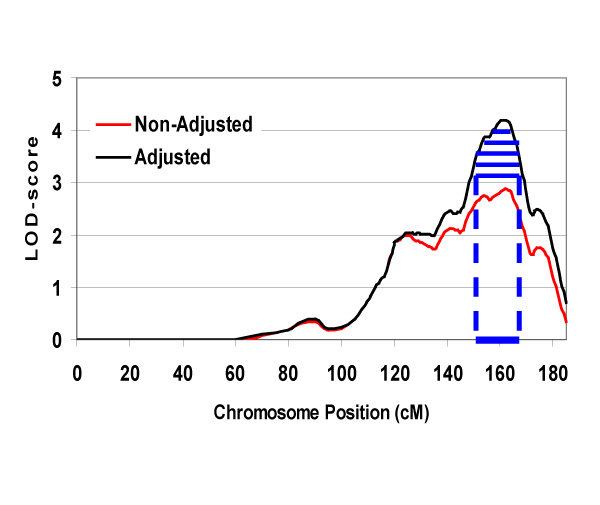
Microsatellite multipoint VC analysis for ttth1 (chromosome 7). Microsatellite marker multipoint VC analyses for quantitative trait ttth1 on chromosome 7.